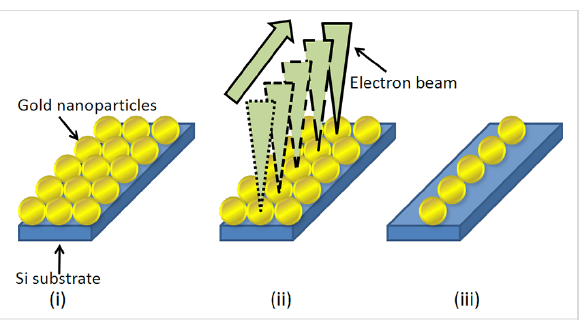
Figure 1: Schematic illustration of the proposed technique. (i) A two- dimensional array of gold nanoparticles is formed on a substrate. (ii) Selected nanoparticles are irradiated with the electron beam to fix these particles on the substrate. (iii) The unfixed particles are washed away, creating an array of nanoparticles.